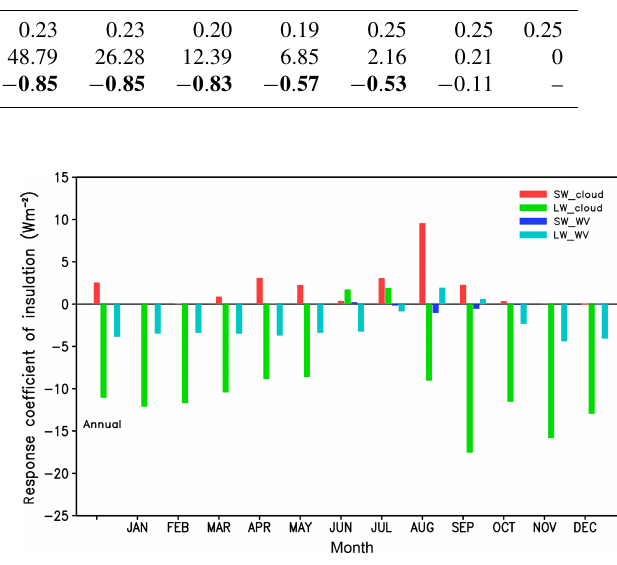
Figure 8. The annual and monthly response coefficients (Wm − 2 ) of net shortwave and longwave radiation flux related to cloud and water vapour change due to the insulation effect of sea ice. Here, the cloud and water vapour change is specified as the part related to sea ice